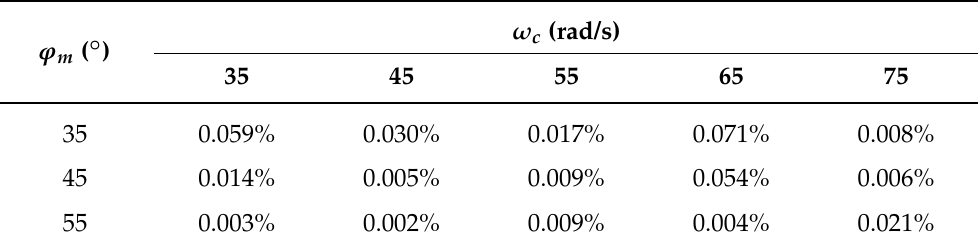
Table 2. Estimation error of the derivative